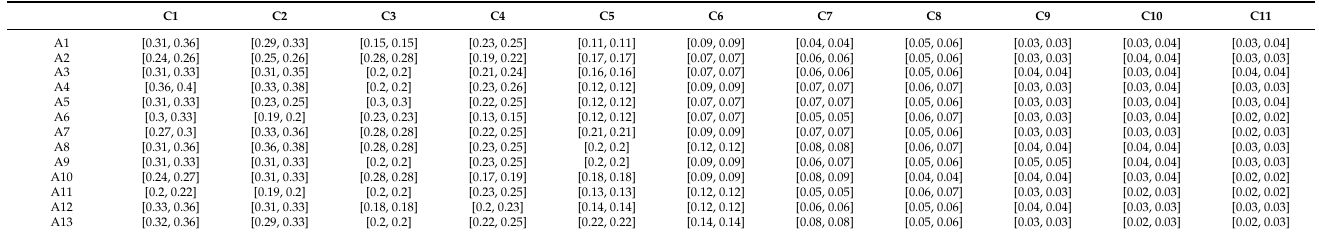
Step 3. Calculation of the elements of weighted matrix ( V ). Applying the expression (29) gives the elements of weighted matrix ( V ) (Table 8): Table 8. Weighted